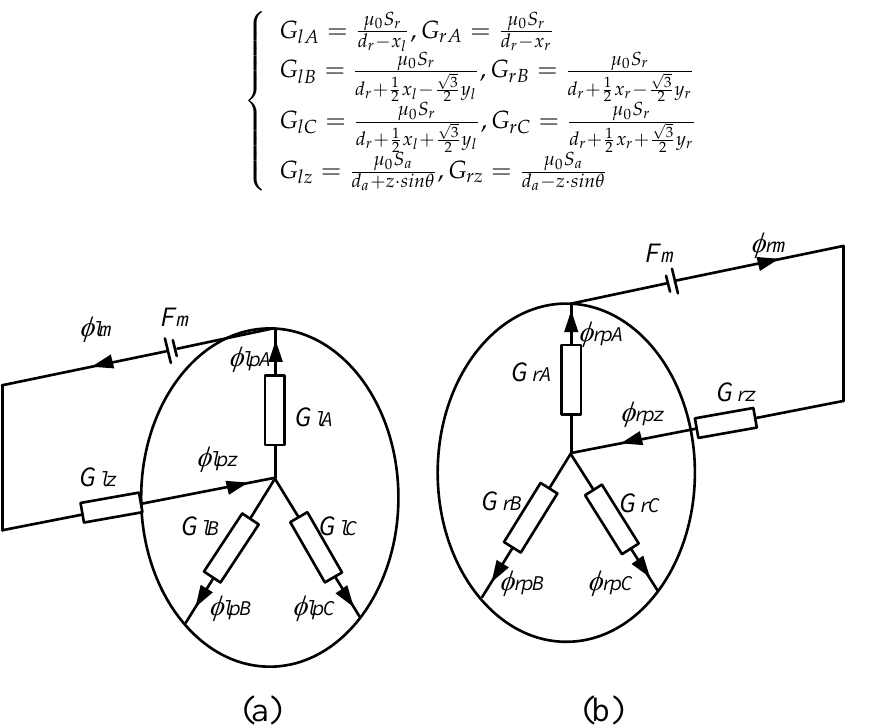
Figure 3. Equivalent bias magnetic circuit: ( a ) left bias fluxes and ( b ) right bias fluxes. Due to the symmetrical structure of the left and right 2-DOF MBs, the geometric dimensions are the